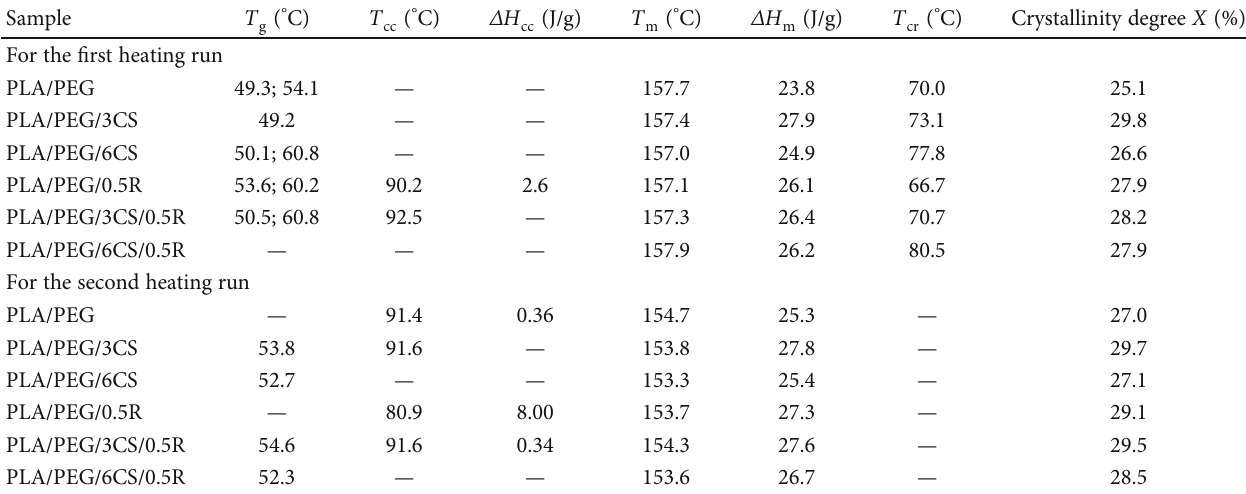
Table 1: Thermal characteristics of the plasticized PLA/PEG/CS/R systems determined by the DSC method.